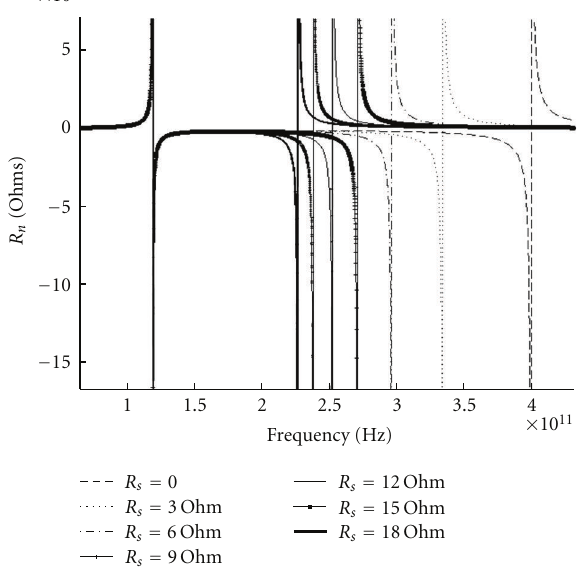
Figure 7: Variation of R n with source resistance R s